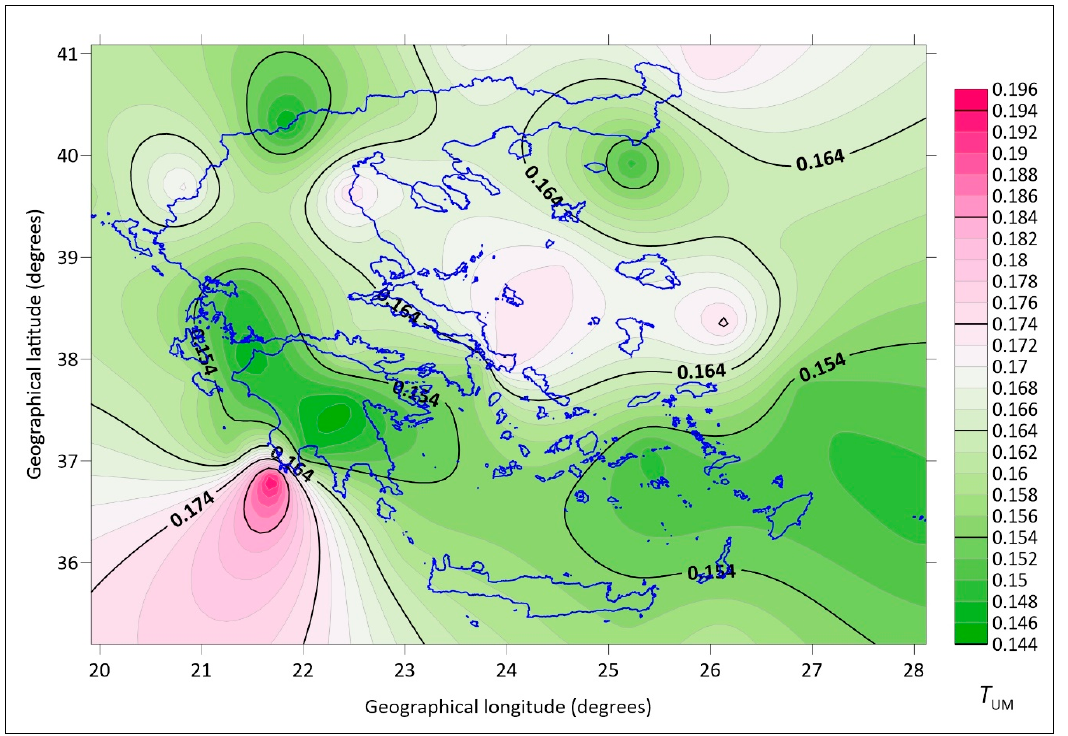
Figure 13. Map of annual mean T UM values over Greece for all (upper graph) and clear-sky (lower graph) conditions during TATY.